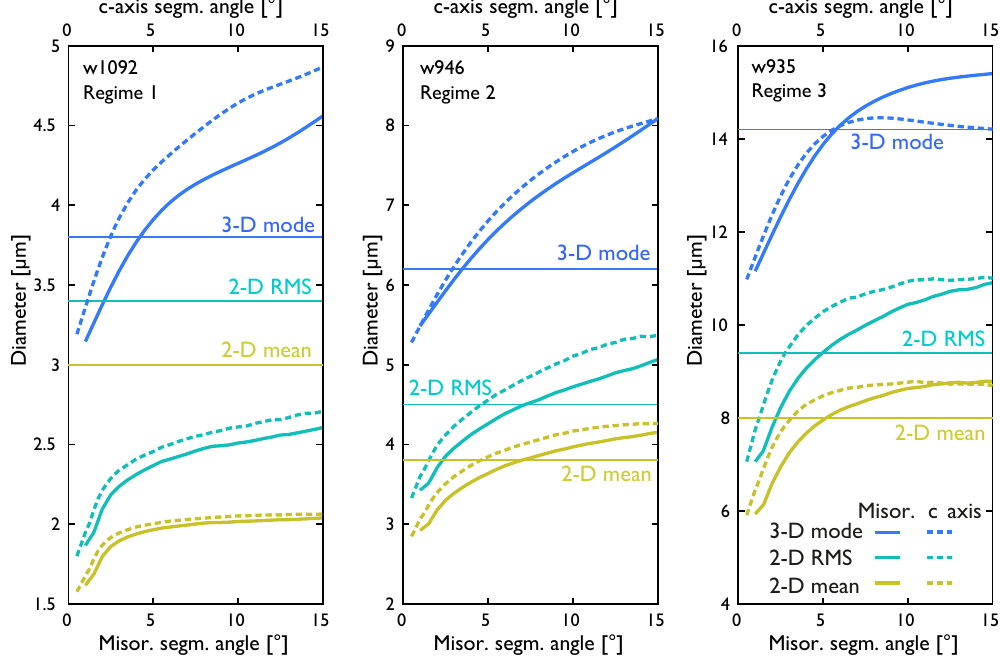
Figure 7. Grain size as a function of segmentation angle. Mean grain sizes calculated without grain completion from full texture data (EBSD maps) using full misorientations (solid lines, bottom x axis) and c -axis misorientation (dashed lines, top x axis). Horizontal lines show values obtained by supervised segmentation of CIP images using c -axis misorientation images, the Lazy Grain Boundaries macro and the StripStar program for 2-D–3-D conversion. Blue: modes of histograms v(D) of volume fractions of calculated 3-D equivalent diameters; turquoise: RMS of measured 2-D equivalent diameters; yellow: arithmetic mean of measured 2-D equivalent